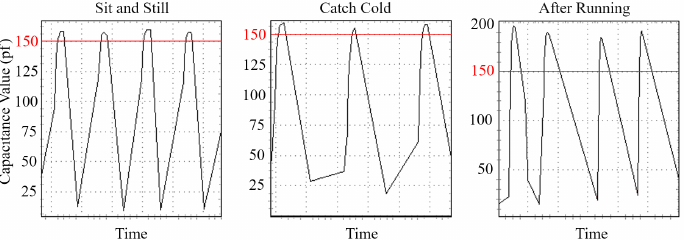
Figure 16. Equivalent capacitance of finger-touching operations under different body conditions. It can be seen from the figure that the user’s finger-touching operation is relatively stable when the user is sitting and still ( left ). When the user has a cold, their behavior changes due to weak body conditions, but the bio-capacitance (peak value) remains stable ( middle ). After strenuous exercise, the sensed bio-capacitance changes dramatically as the sweat changes the body conductivity ( right